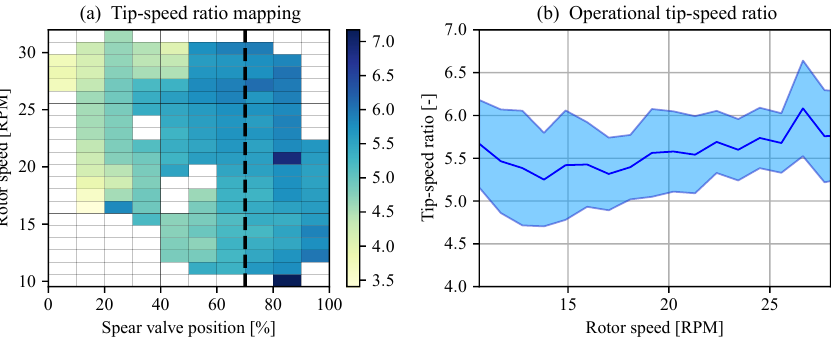
Figure 21. Tip-speed ratio mapping as a function of spear valve position and rotor speed (a) . The dashed line indicates the fixed spear position selected for below-rated passive torque control. Panel (b) shows the corresponding evaluation of the tip-speed ratios along this path with 1 σ standard deviation